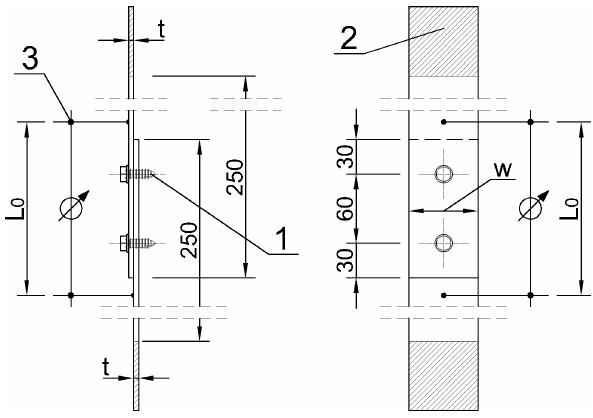
Figure 1: Geometry of single specimen; 1-self drilling screw HILTI S-MD 01 Z 5,5x19; 2-grip area, 3-reference points for extensometer